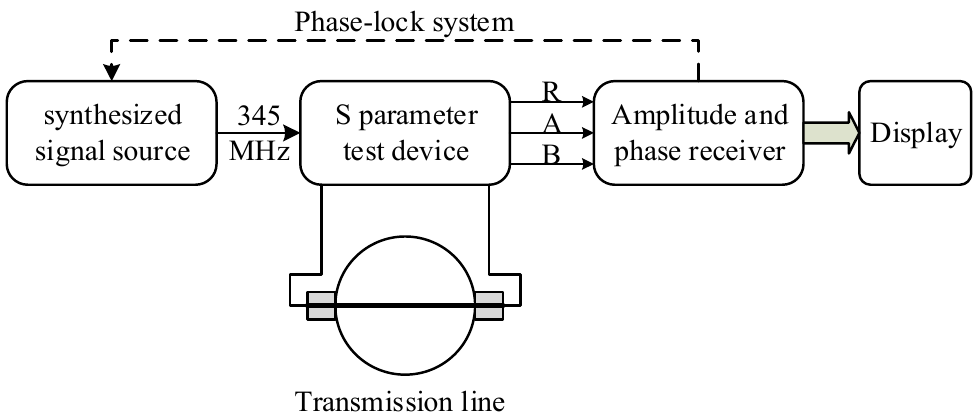
Figure 1. A photograph of the experimental platform and device: ( a ) the experimental platform; ( b ) the microwave transmission device.